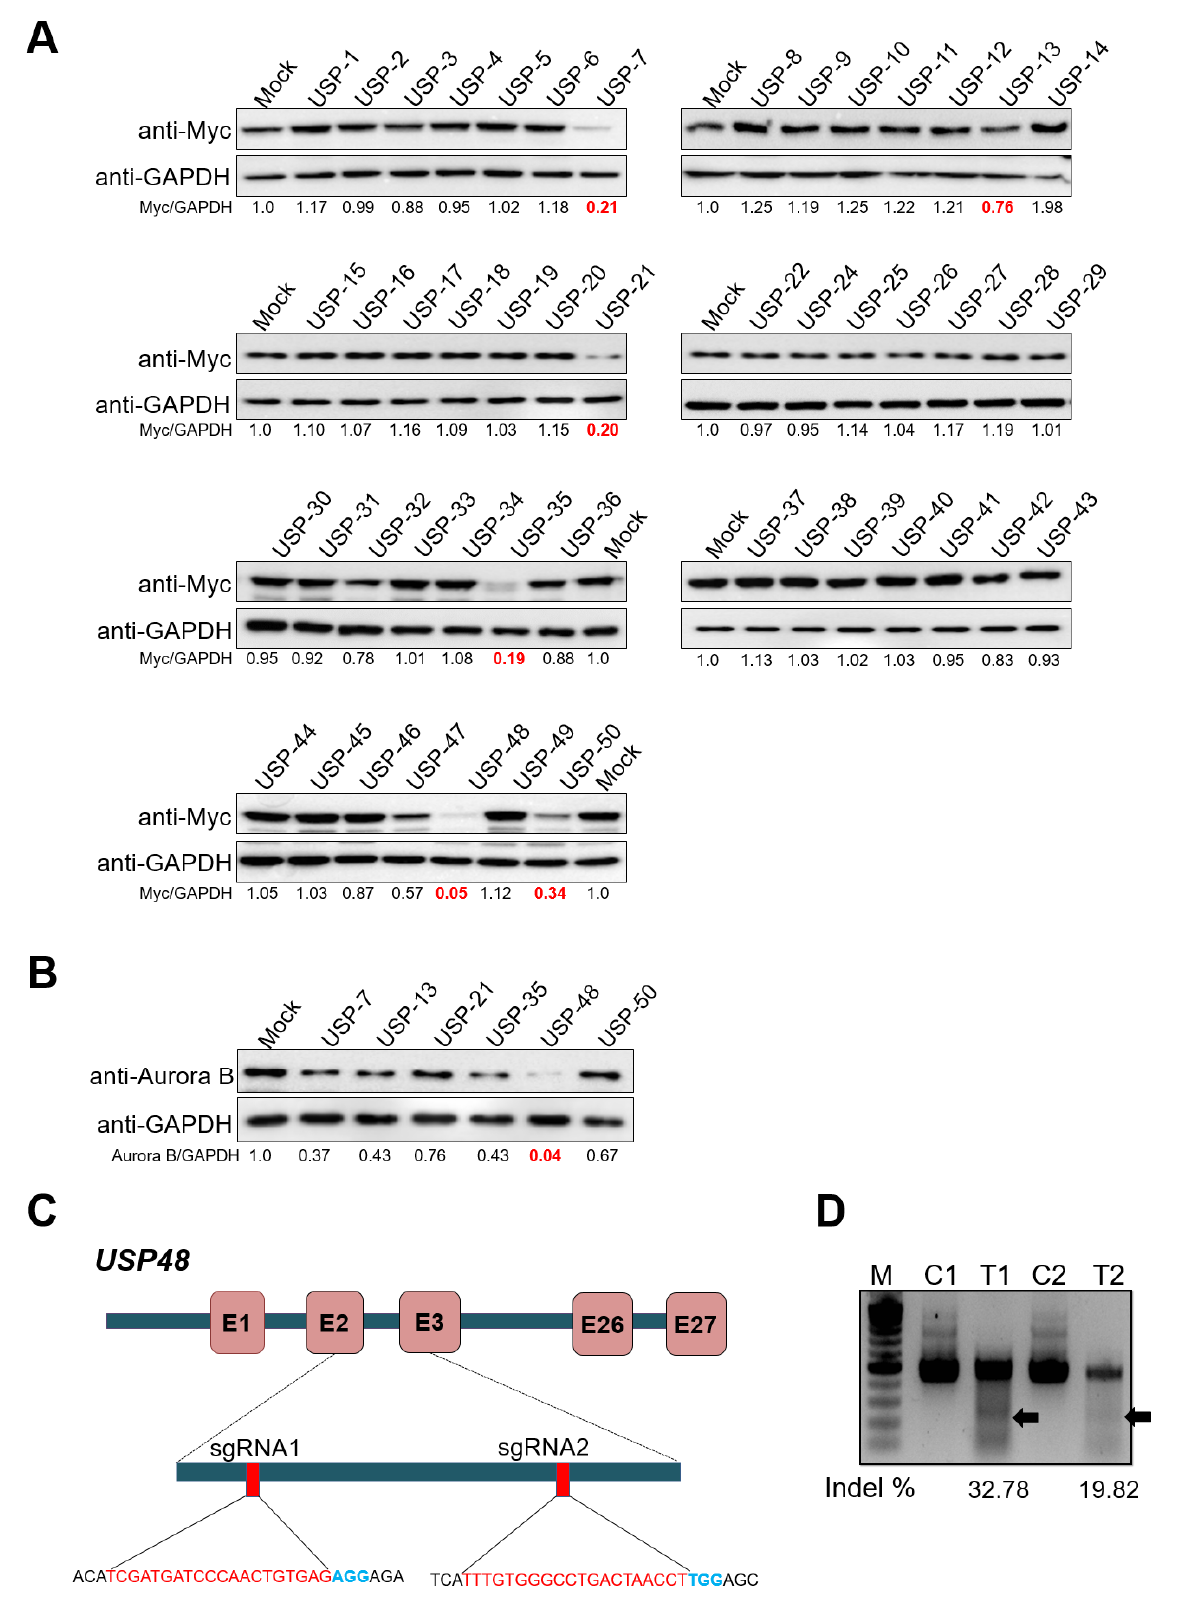
Figure 1. CRISPR-based genome-scale screening of USP sub-family proteins exhibiting a reduction in Aurora B protein levels. ( A ) Screening for DUBs regulating Myc-Aurora B was performed using a CRISPR-Cas9-based DUBKO sgRNA kit. HEK293 cells were transfected with Myc-Aurora B and the indicated sgRNAs along with Cas9. Equal concentrations of proteins from DUBKO HEK293 cell lysates were subjected to Western blot analyses. The protein band intensities were